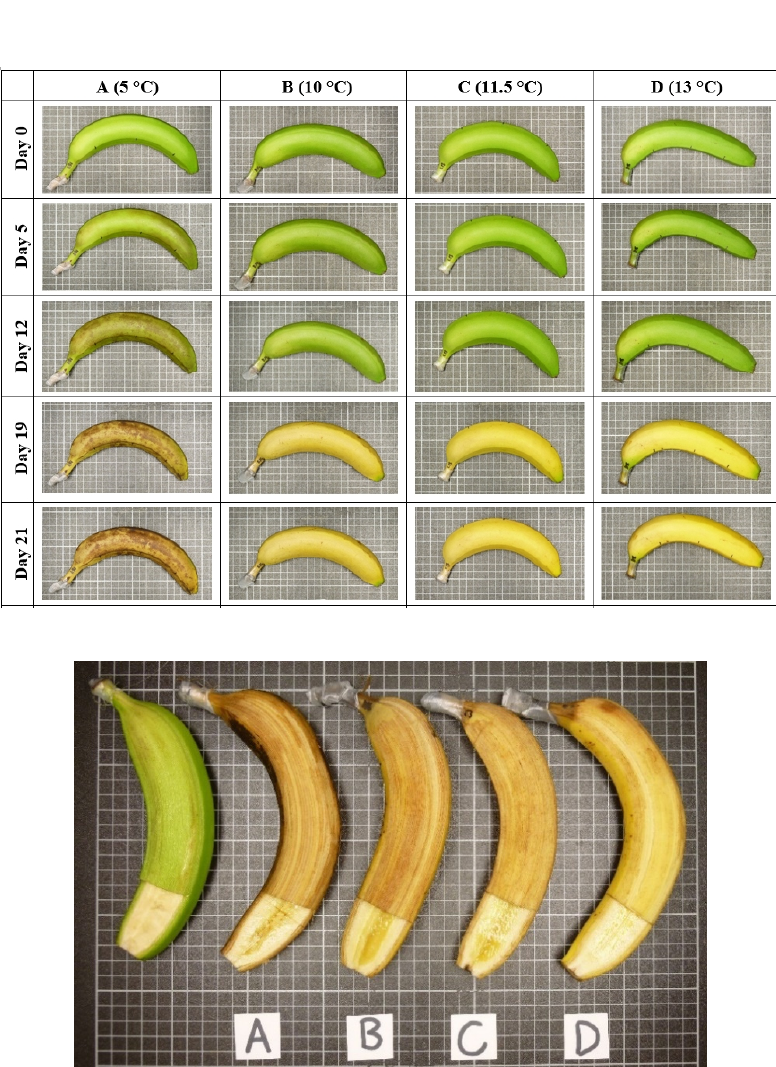
10 of 16 Figure 6. Means (±SD, n = 6) of the normalized difference vegetation index (NDVI), the photochemical reflectance index (PRI), the chlorophyll to carotenoid ratio, and the carotenoid index of banana fruit measured during cold storage (  circles: 5 °C;  squares: 10 °C; Δ triangles: 11.5 °C;  diamonds: 13 °C) and shelf life. The vertical dashed line indicates the end of cold storage on day 12 of the experiment. The filled circles reflect the means (the grey horizontal bar shows the respective SD) of all bananas ( n = 76), measured before storage. Different small letters indicate significant ( p < 0.05) differences between means. 3.3. Chilling Stress Effects on Overall Appearance